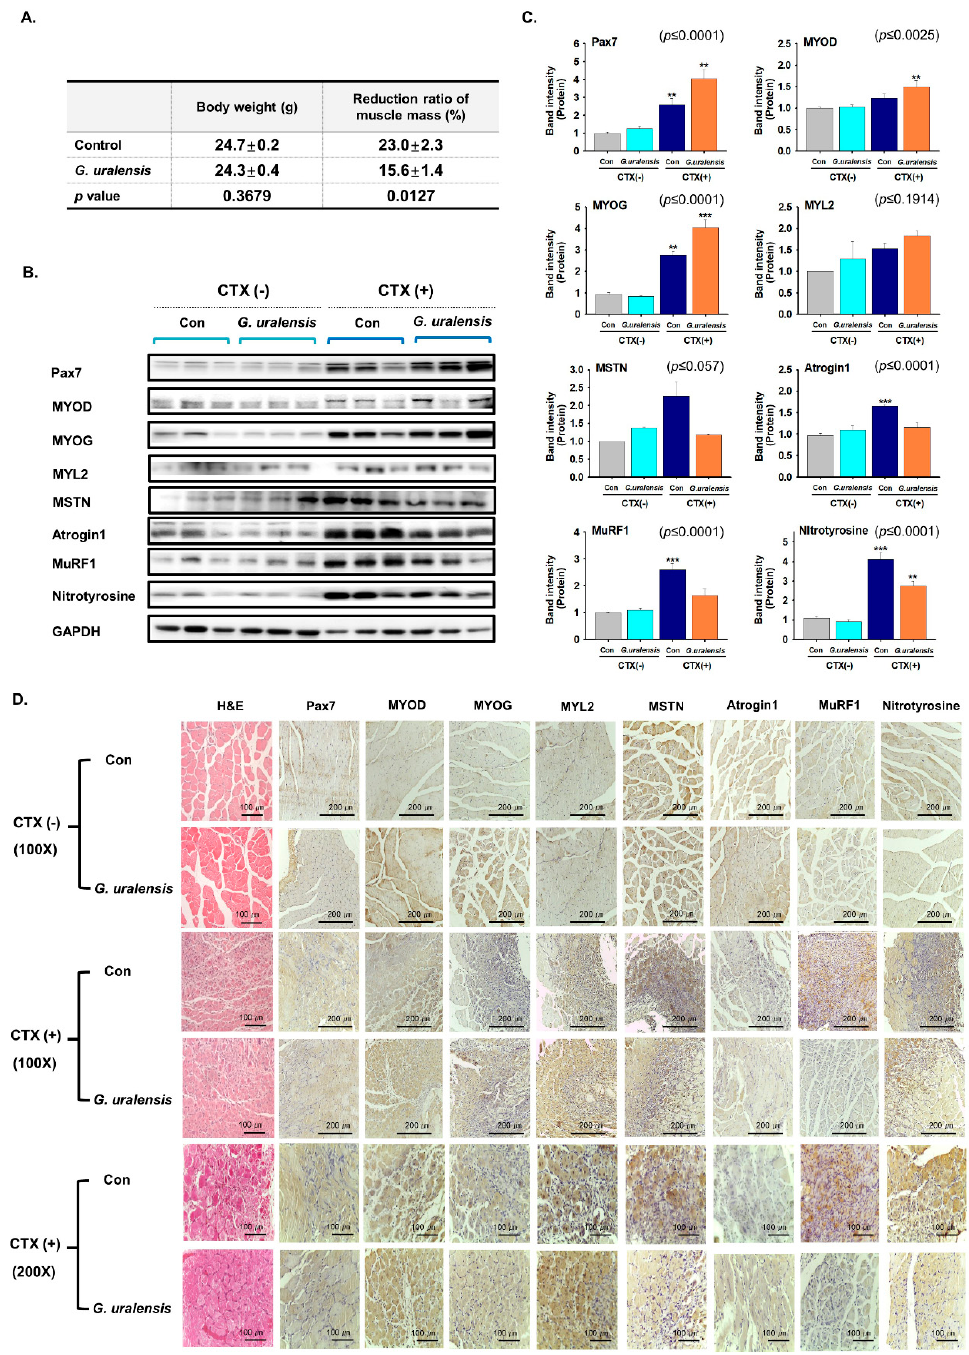
Figure 2. Muscle regeneration by the CWE of G. uralensis . Mice were orally administered G. uralensis CWE (100 mg/kg) daily for nine days from one day before CTX injection. Seven days after CTX injection, gastrocnemius muscle tissues were collected from control (intact or CTX injected animals) and G. uralensis CWE treated animals and from treatment naïve controls. ( A ) Body weights (g) and reductions in muscle mass (%). ( B , C ) Protein expression was determined by Western blotting and band intensities using Multi Gauge 3.0 software. ( D ) H&E staining and protein expression as determined by immunohistochemistry. Con indicates control. Means ± SDs ( n = 9). ** p ≤ 0.001, *** p ≤